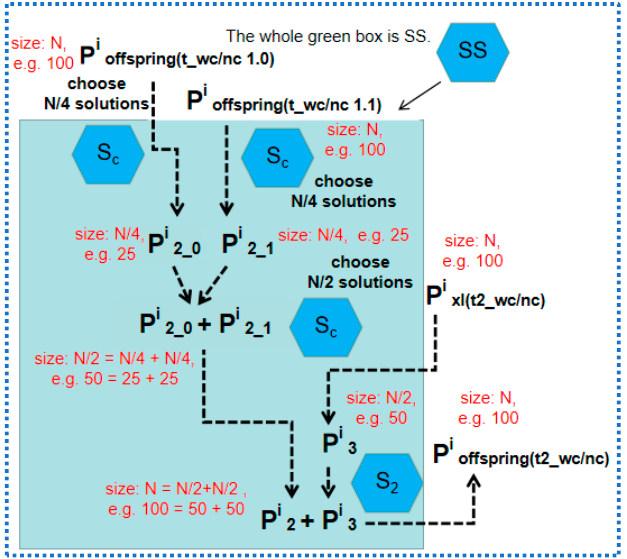
Figure 6. The details of operator SS [5] are shown above. In SS, we have many sub-operators for selection purposes. Actually, our robustness of SMO frameworks mainly relies on the performing of SS. Therefore, we tend to believe that SS is the “transfer